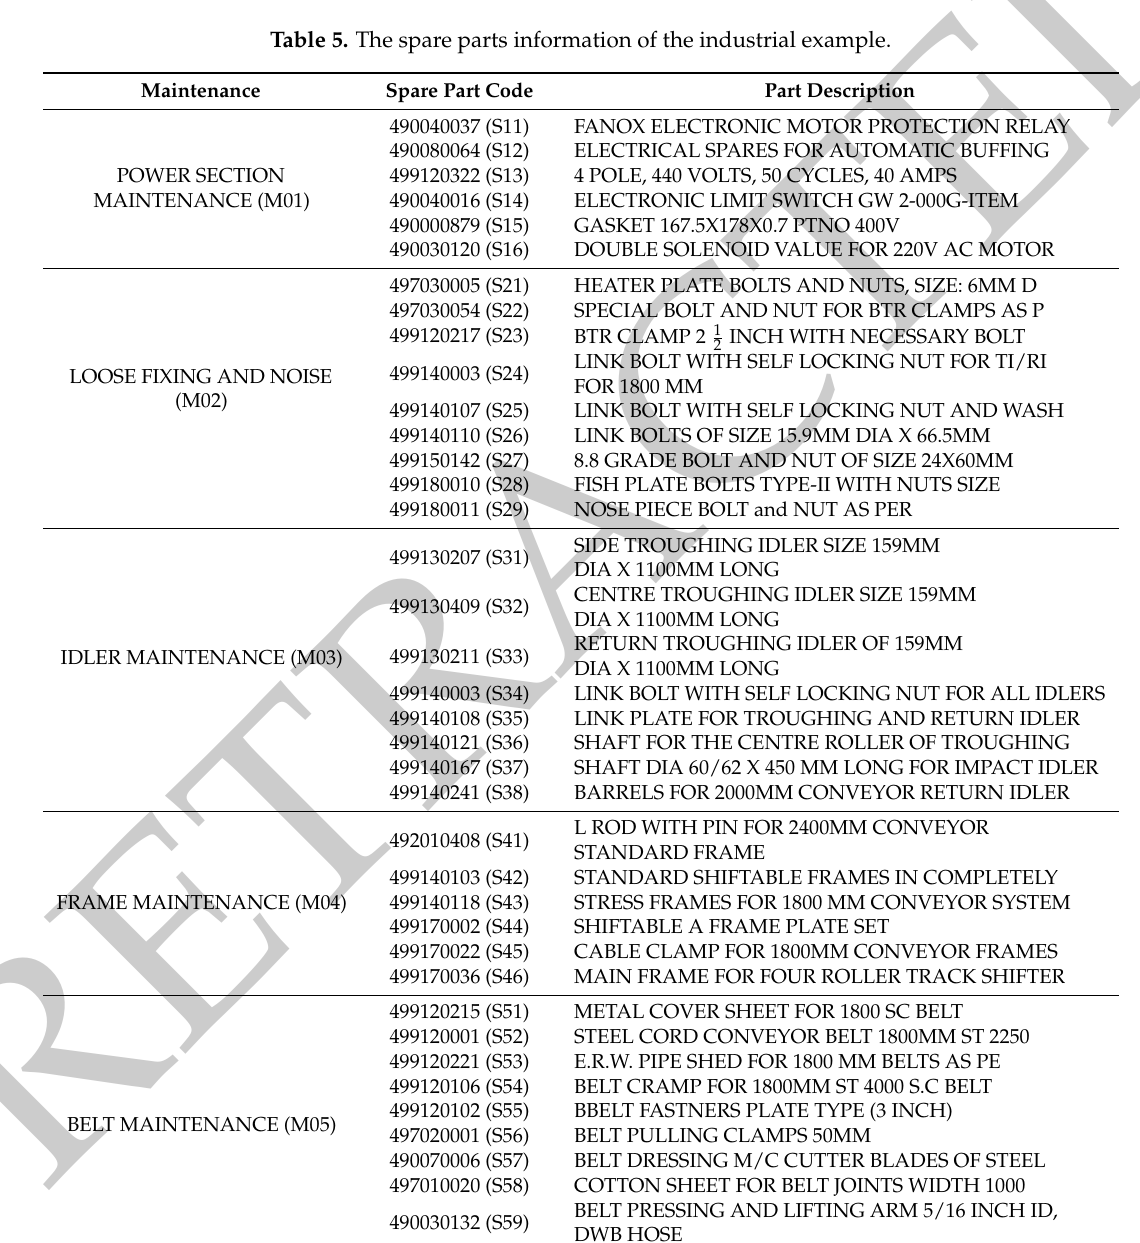
Table 5. The spare parts information of the industrial